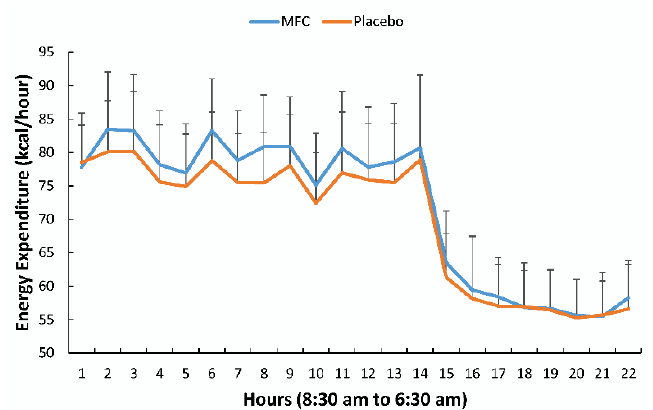
than placebo ( p < 0.001) when AUCs were compared as a whole and for each defined segment except during sleep.